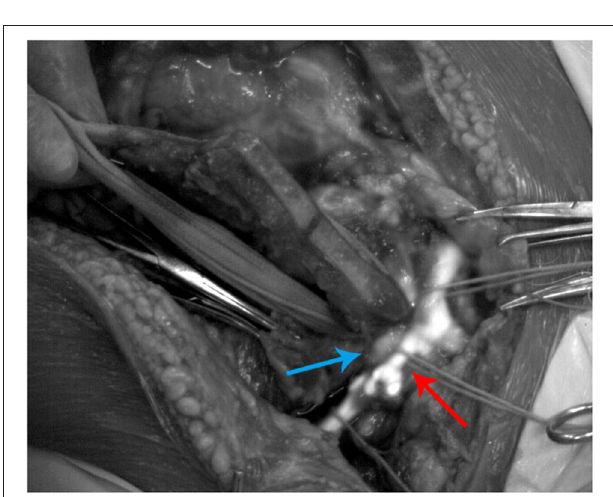
FIGURE 2 | Second near-infrared (NIR-II) indocyanine green (ICG) angiography of the left subclavian vein (red arrow) and the left subclavian artery (blue arrow) during the